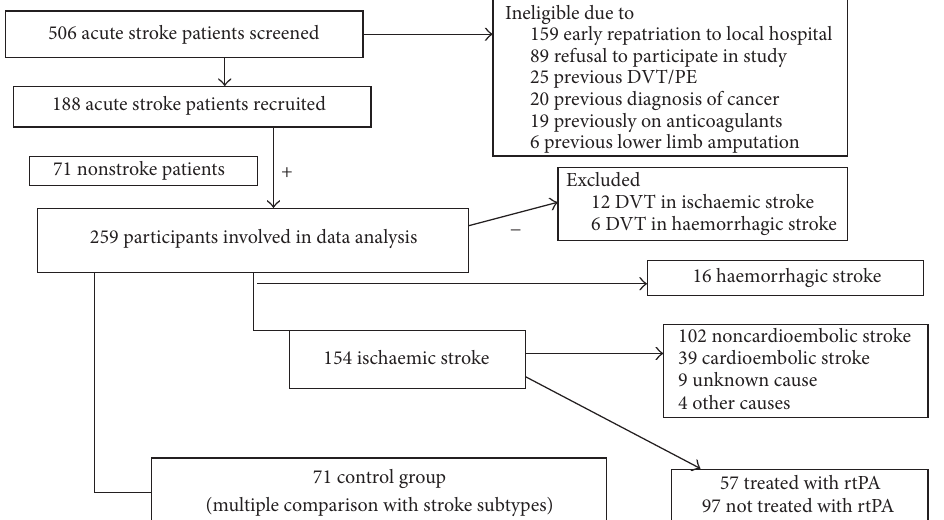
Figure 1: Flowchart of recruitment of participants. AIS: acute ischaemic stroke; DVT: deep vein thrombosis; PE: pulmonary embolism; rtPA: recombinant tissue plasminogen